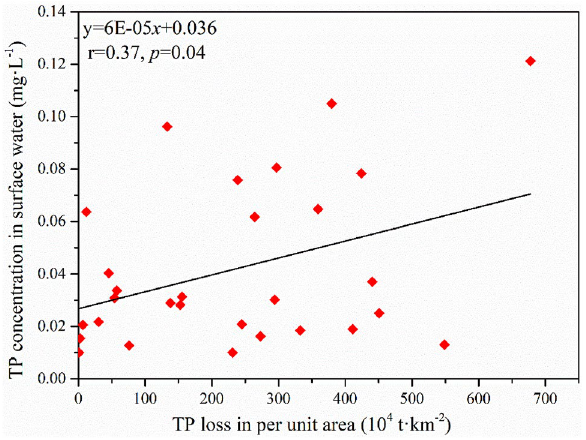
Figure 3. The linear regression between TP loss in per unit area of planting and TP concentration in surface